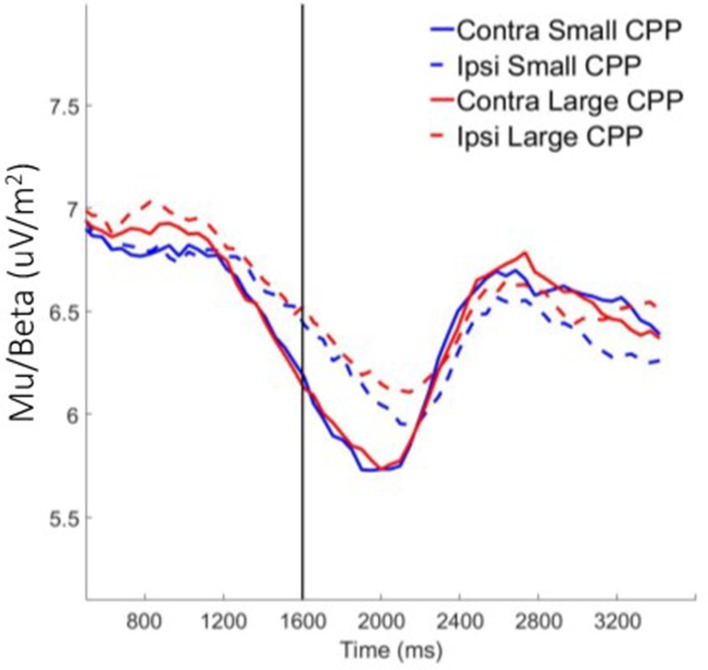
Contralateral and ipsilateral motor preparation as a function of pre-evidence CPP amplitude bin (large versus small based on median split).